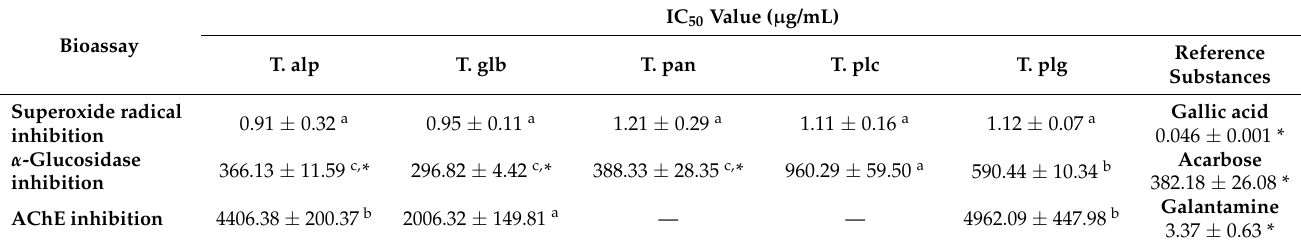
Table 3. Overview of in vitro superoxide radical-scavenging activity and enzymatic inhibition potential of Thymus